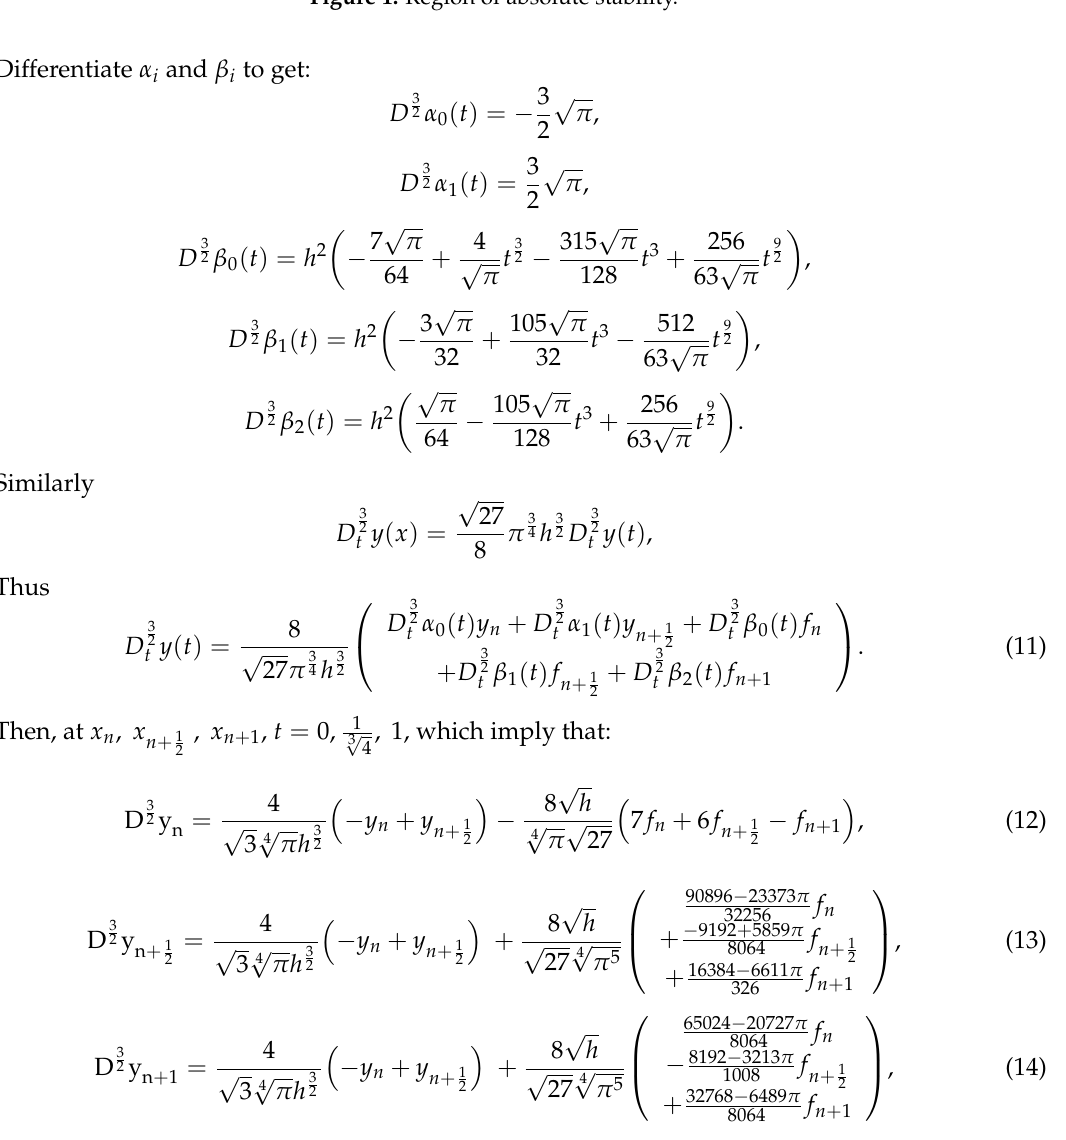
Figure 1. Region of absolute stability.